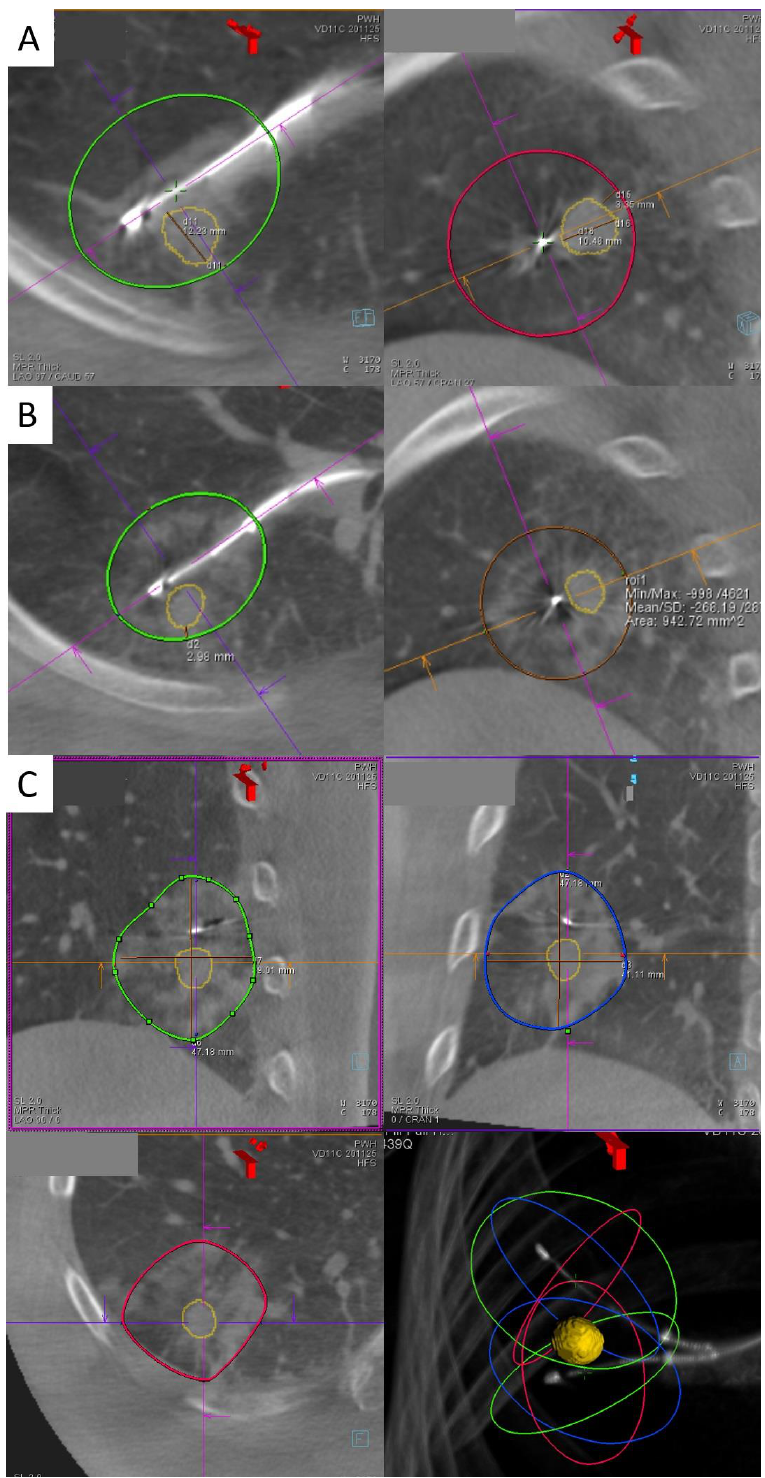
Figure 1. ( A , B ) Right lower lobe lung lesion before ( A ) and after ( B ) the first transbronchial microwave ablation in two axes on a cone beam CT scan. The lesion is marked by orange tracings while the green and red ovals represent the predicted ablation zone. In ( B ), ablative changes represented by ground glass opacities are seen surrounding the ablation catheter as predicted; however, the margin was only 2 mm. Therefore, repositioning of the ablation catheter and re-ablation were performed as shown in ( C ), and the final cone beam computer tomography (CBCT) shows a satisfactory margin of 6.7 mm.